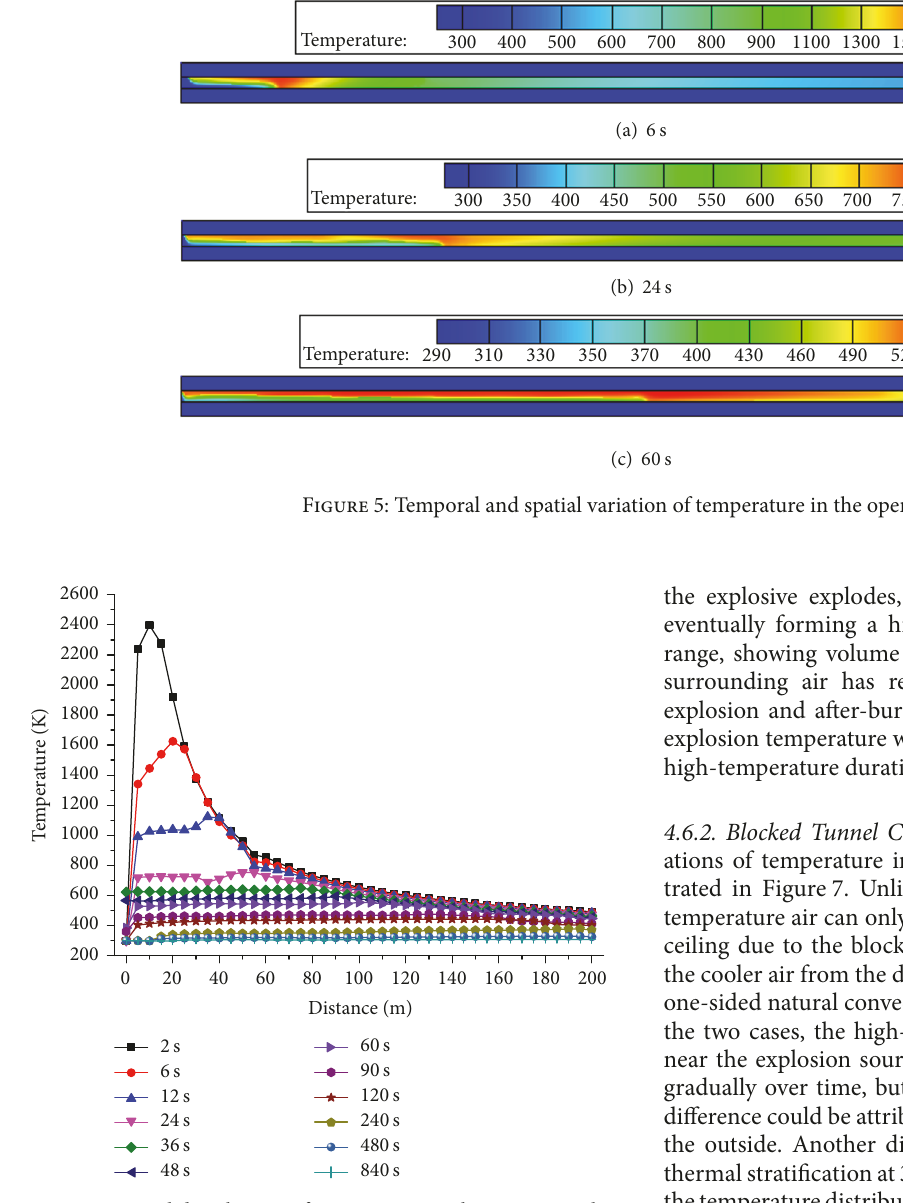
Figure 6: Spatial distribution of temperature in the open tunnel at different